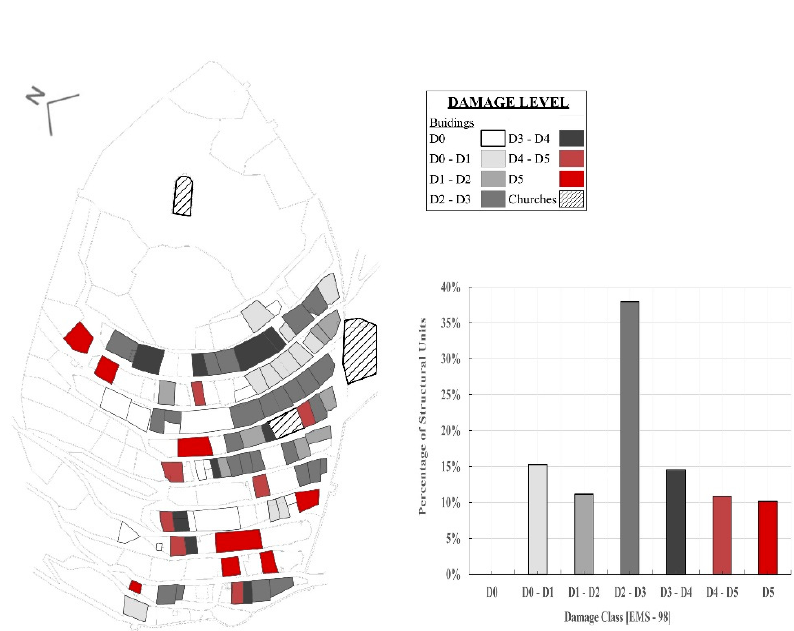
Figure 6. Mapping of the damage observed in Campi Alto di Norcia, according to the European Macroseismic Scale (EMS)98.